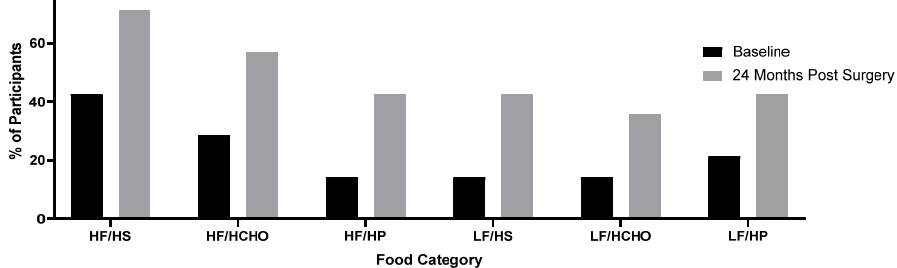
Figure 3. Proportion of Participants Not Consuming Items from Each Category, baseline versus 24 months. Percentage of participants not consuming each category at baseline and at 24 months post-surgery. HF/HS = High Fat/ High Sugar, HF/HCHO = High Fat/High Complex Carbohydrates, HF/HP = High Fat/High Protein, LF/HS = Low Fat/High Sugar, LF/HCHO = Low Fat/High Complex Carbohydrates, LF/HP = Low Fat/High Protein.